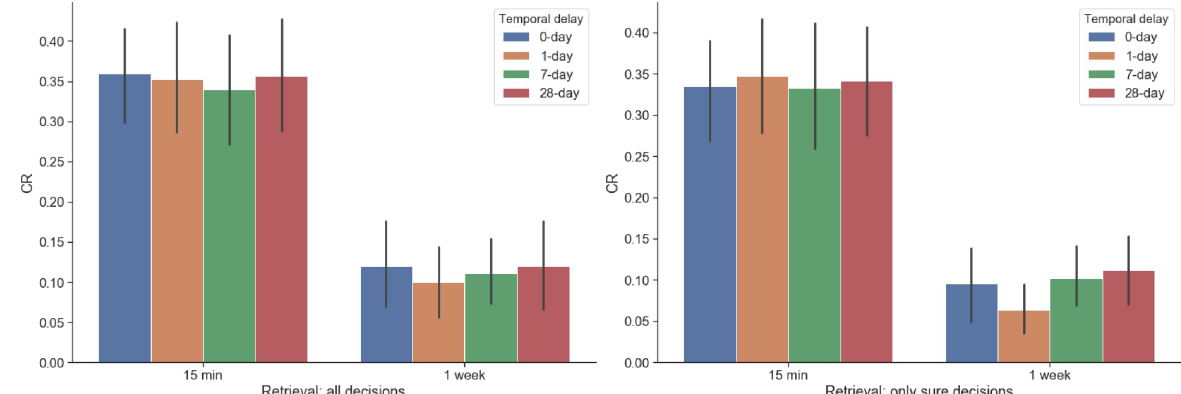
Fig 2. Corrected recognition (CR). Error bars indicate standard deviation, 15 min = retrieval right after encoding, 1 week = retrieval 1 week after encoding, (left) CR using both sure and guessed responses (right) CR using only sure